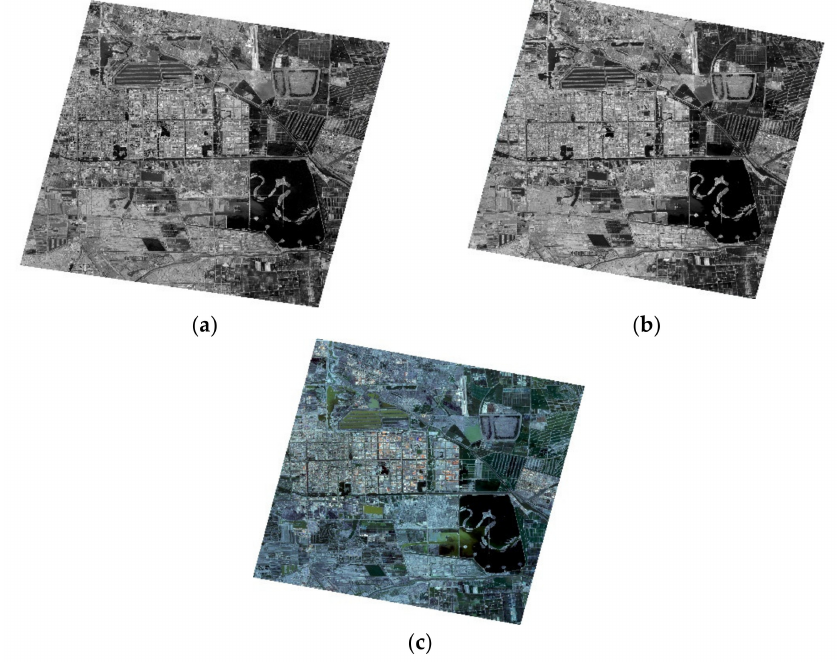
Figure 7. GF-7 DLC and MUX images used for the experiment: ( a ) forward image, ( b ) backward image, and ( c ) multispectral